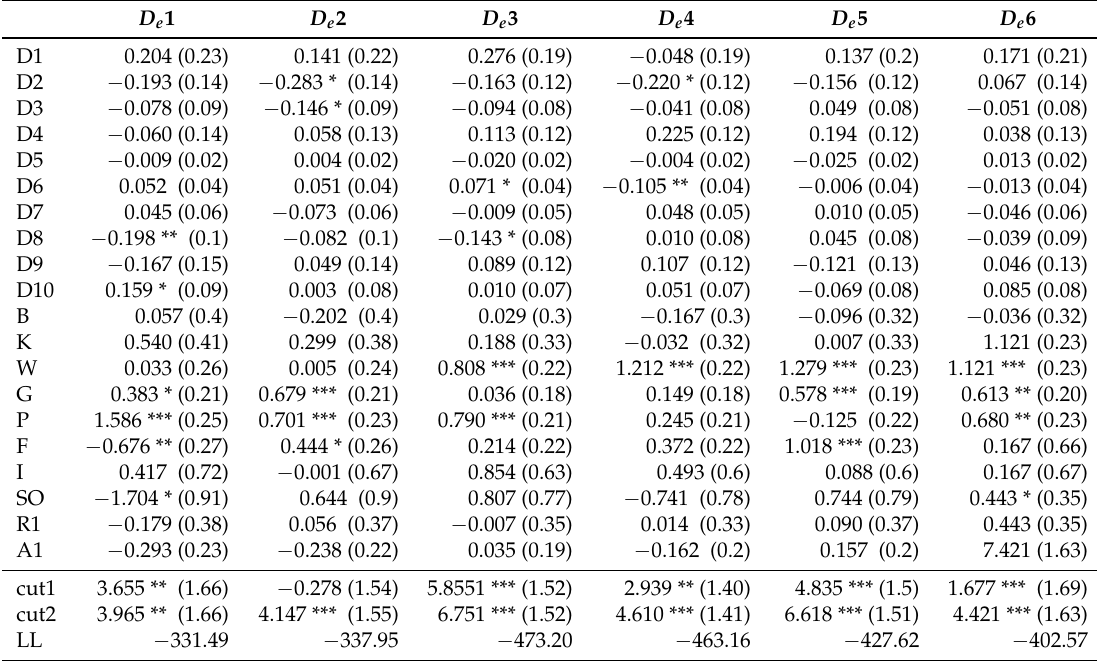
Table 4. Estimation results for ordered logit model (N = 496).